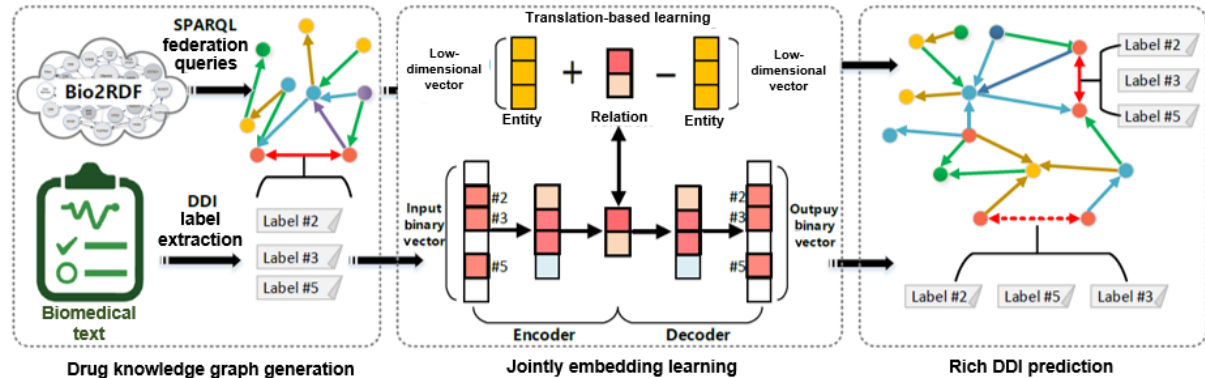
Figure 1. Overview of the framework. DDI: drug-drug interaction.